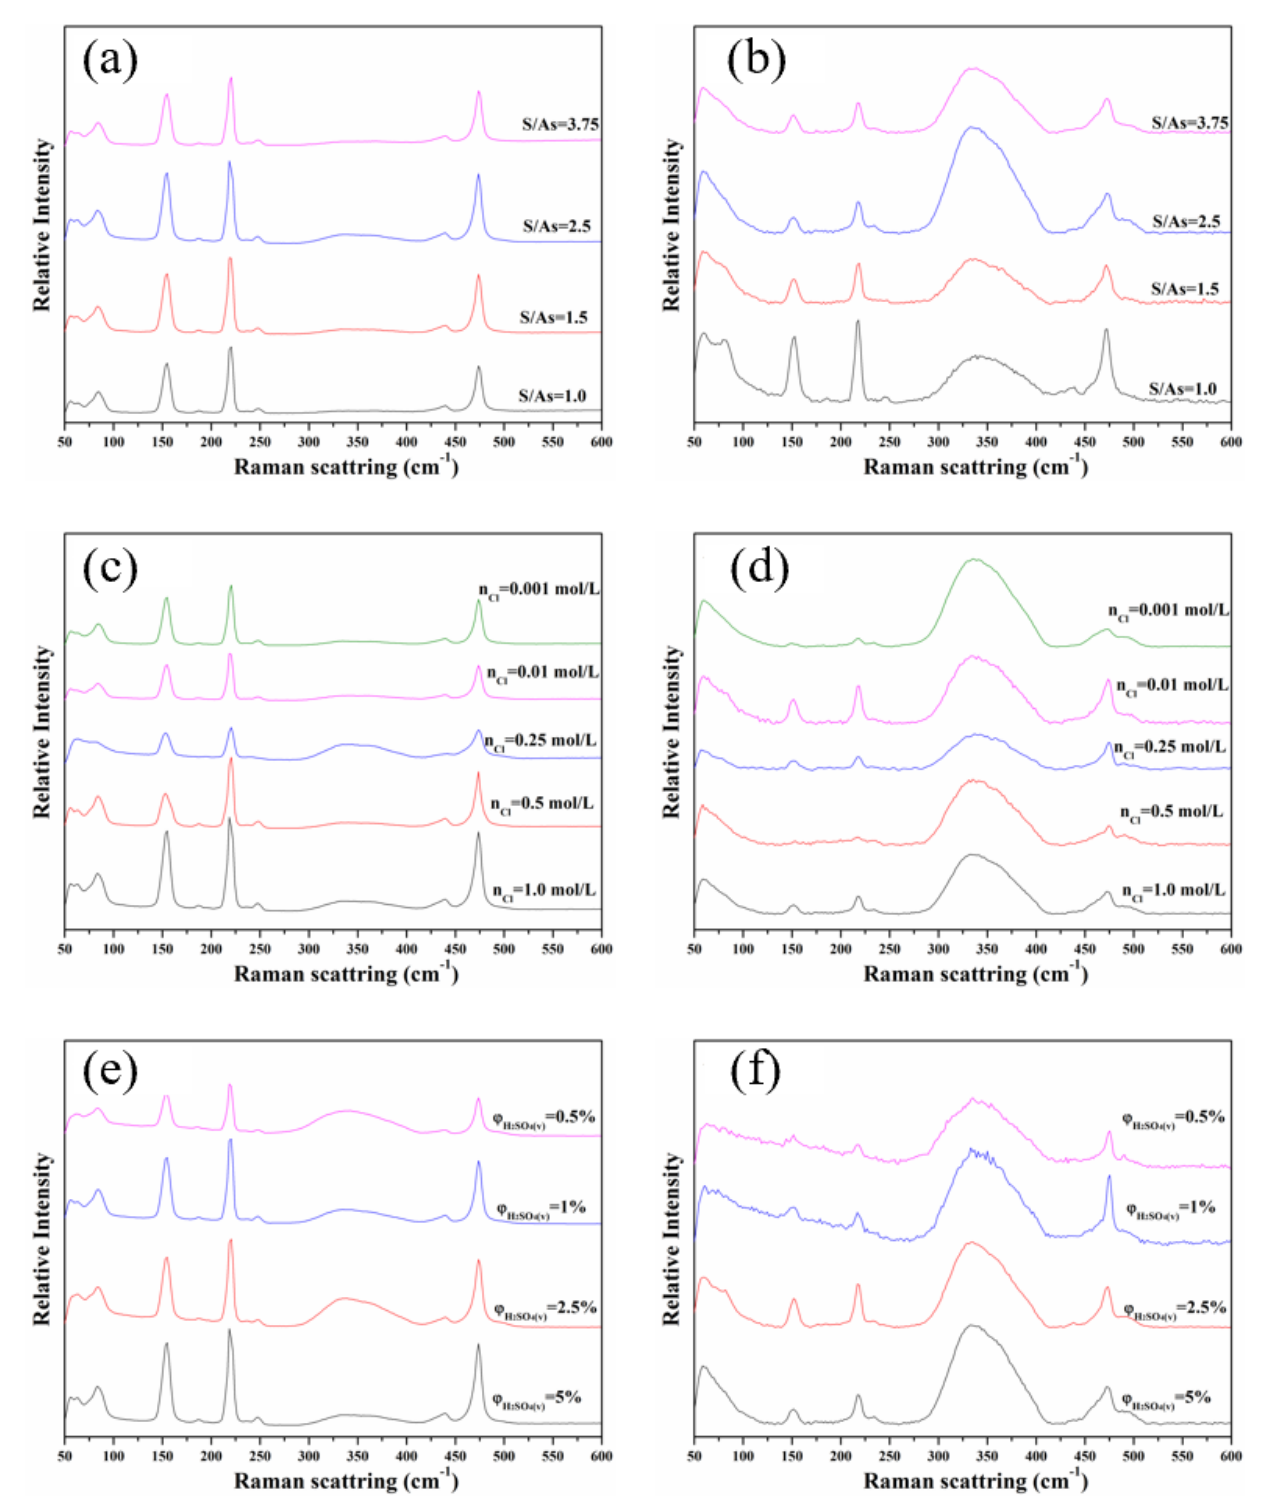
Figure 10. Raman spectra of the precipitates-As(V): ( a ) different S(-II)/As(V) at 0 ◦ C; ( b ) different S(-II)/As(V) at 30 ◦ C; ( c ) different c Cl − at 0 ◦ C; ( d ) different c Cl − at 30 ◦ C; ( e ) different ϕ H2SO4(v) at 0 ◦ C; ( f ) different ϕ H2SO4(v) at 30 ◦